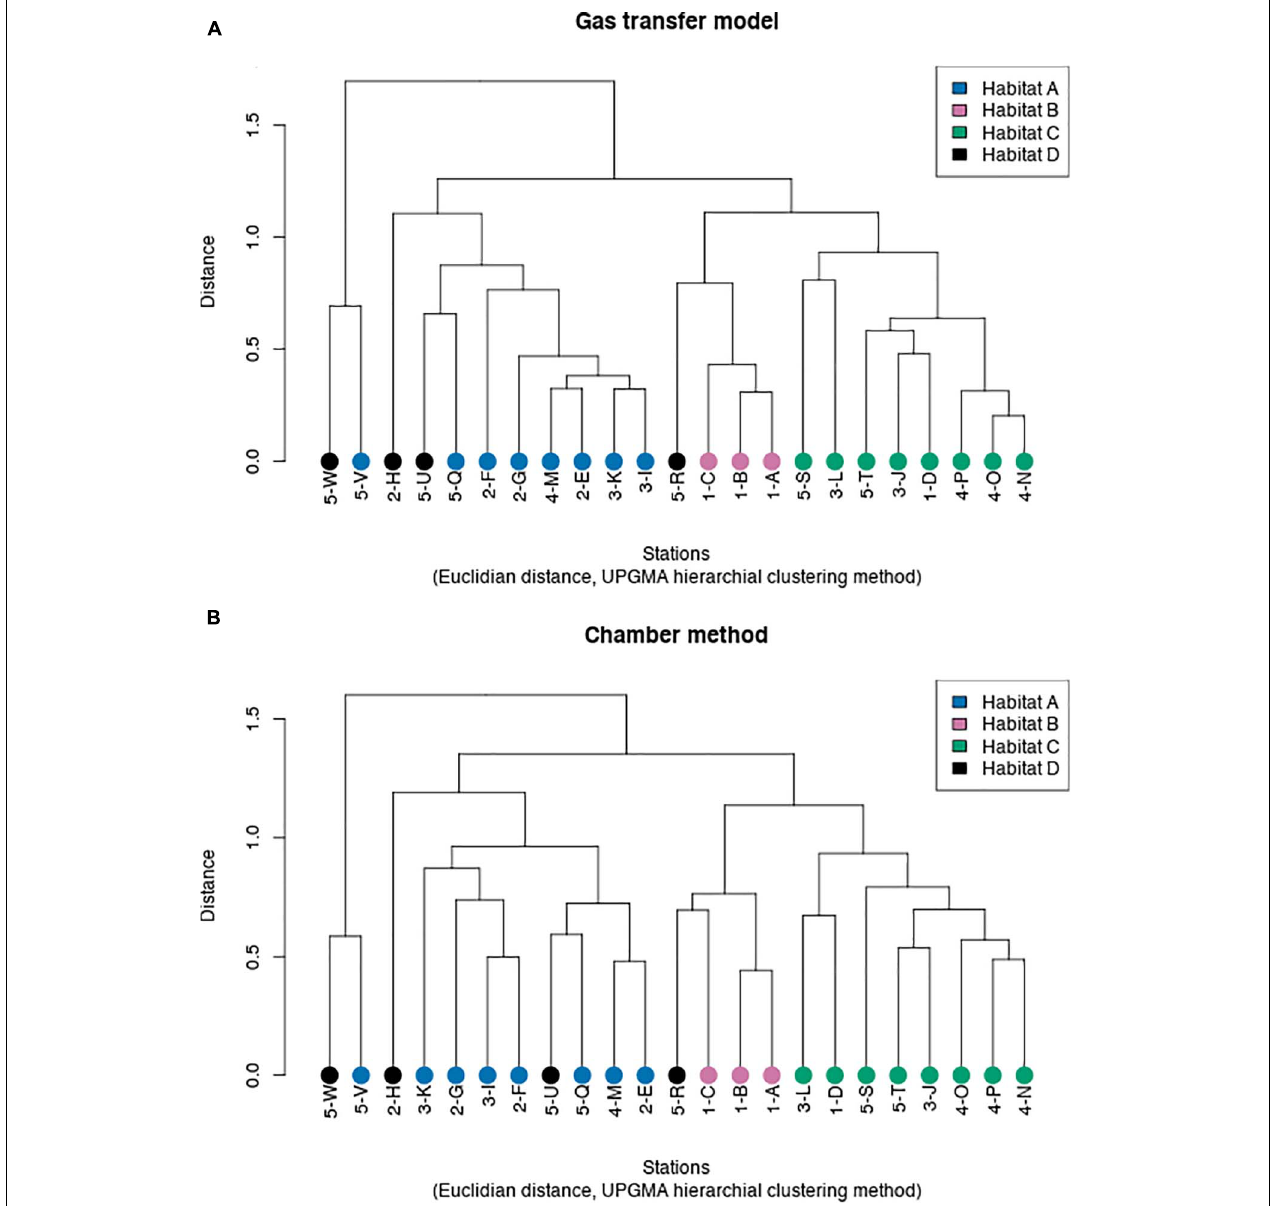
FIGURE 7 | Hierarchical clustering of habitats as a function of CH 4 flux relative to environmental forcing factors for the gas transfer model (A) and the unshielded chamber method (B)